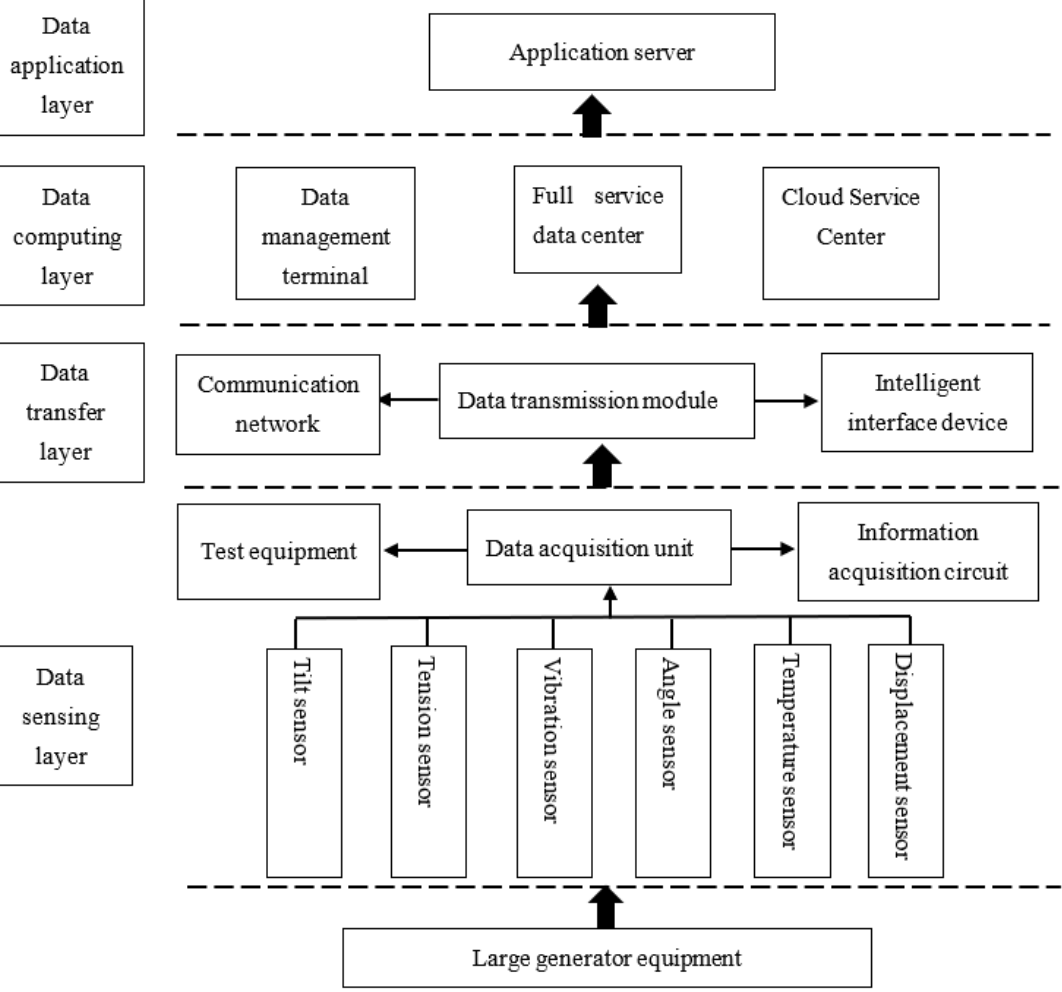
Figure 2. Online data processing system of generator.